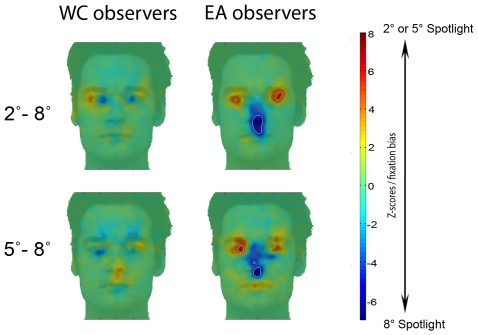
Fixation biases specific to the 8° Spotlight.
Top left: differential fixation maps computed by subtracting the fixation map for Western Caucasian (WC) observers obtained in the 2°Spotlight condition with the 8° Spotlight. Bottom left: differential fixation maps computed by subtracting the fixation map for Western Caucasian (WC) observers obtained in the 5°Spotlight condition with the 8° Spotlight. Top and Bottom right: report the same comparisons, in their respective conditions, for the East Asian (EA) observers. Note that significant differences were only observed for East Asian observers, which deployed a central fixation bias only in the 8°Spotlight condition and focused on the eye region in the 2° and 5° constrained Spotlight conditions.